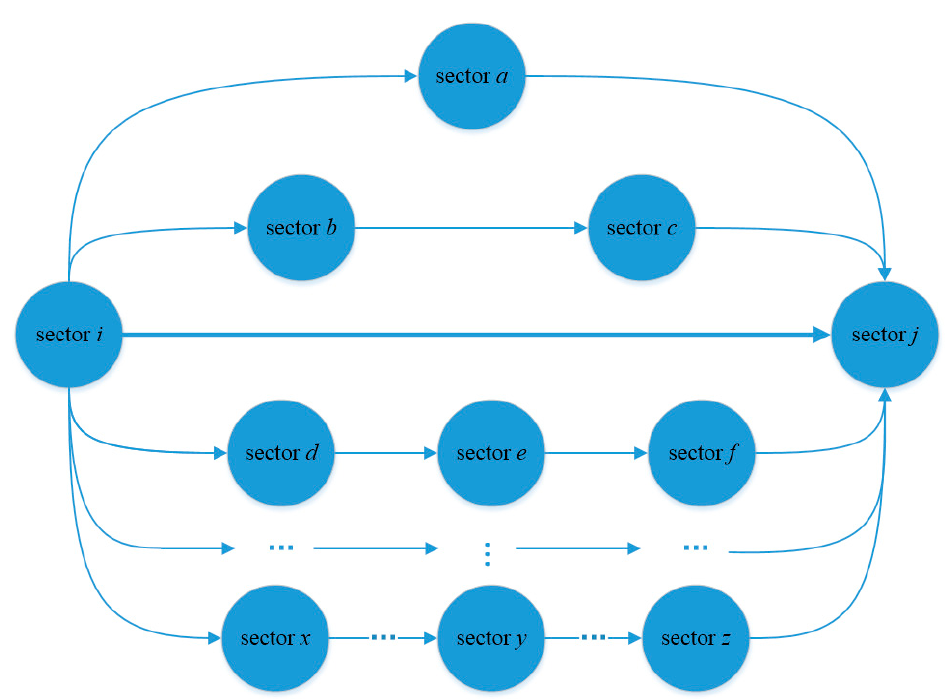
Figure 2. Illustration of total EF flows from i to sector j.